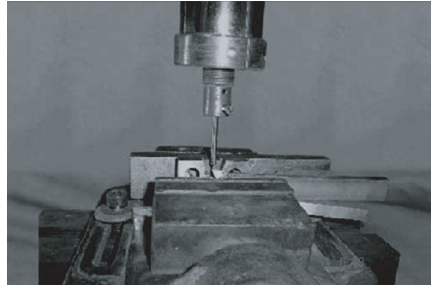
Figure 3: After glazing group A top view.